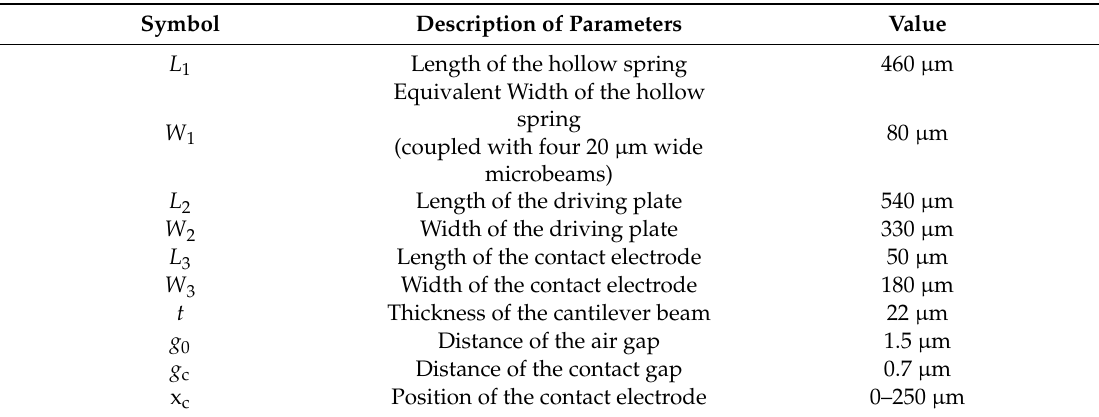
Table 1. Geometric parameters of the proposed MEMS